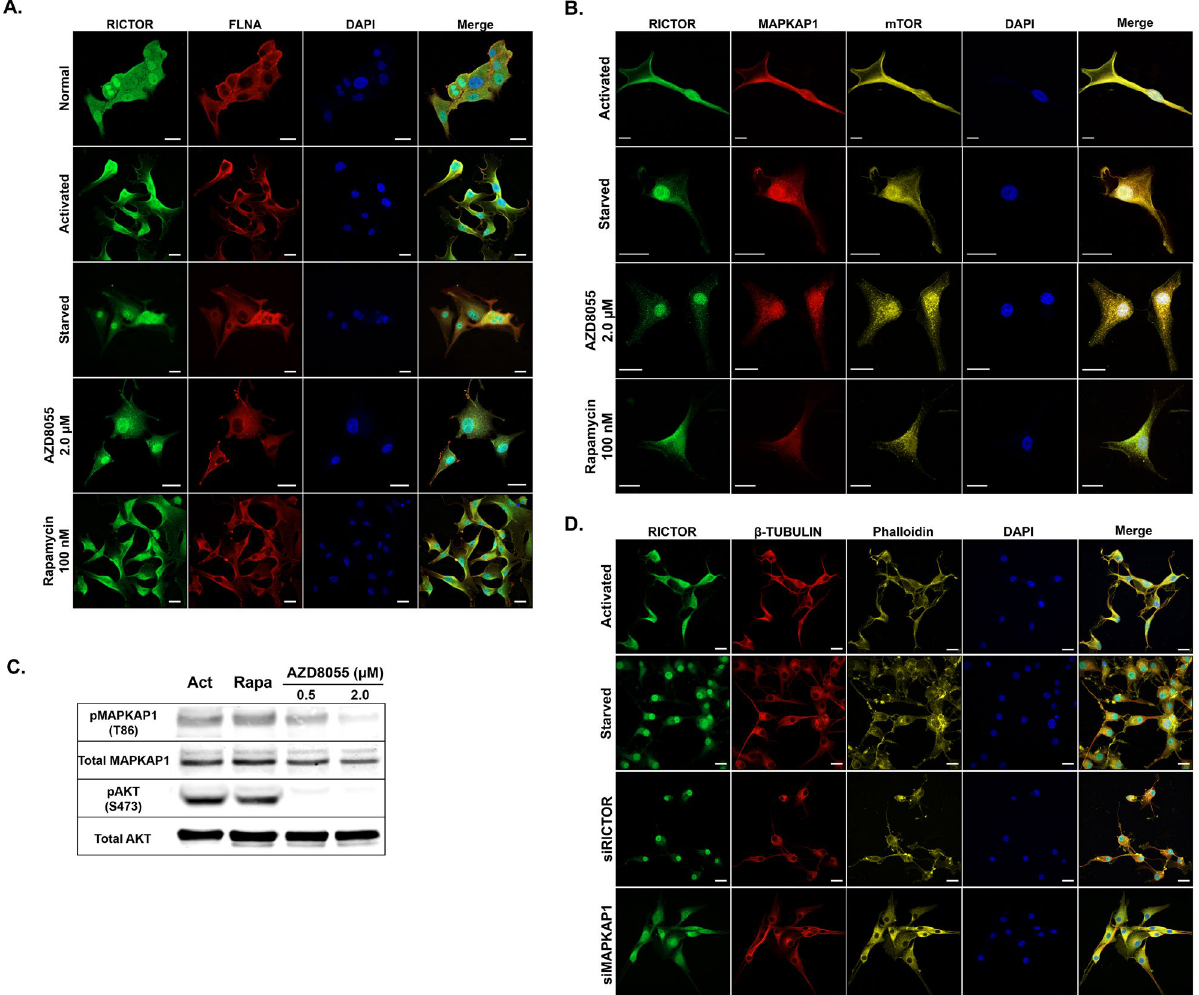
Figure 2. mTORC2 localization, integrity, and effects on cytoskeleton rearrangement. (A) Immunofluorescence analysis showing localization of RICTOR and FLNA proteins in U87MG cells under normal, activating, and three inhibition conditions. Scale bar, 20 µm. (B) Immunofluorescence analysis showing the localization of RICTOR, MAPKAP1, and mTOR proteins in U87MG cells under activating and three inhibitory conditions. Scale bar, 20 µm. (C) Western blot analysis showing mTORC2 complex integrity (pMAPKAP1) and activity (pAKT) in U87MG cells treated with rapamycin and AZD8055 compared to activation conditions. (D) Immunofluorescence analysis showing the localization of RICTOR and the characteristics of F-actin (phalloidin) and microtubules (β-TUBULIN) in U87MG cells under activation and knockdown conditions (siRICTOR and siMAPKAP1 treatments). Scale bar, 20